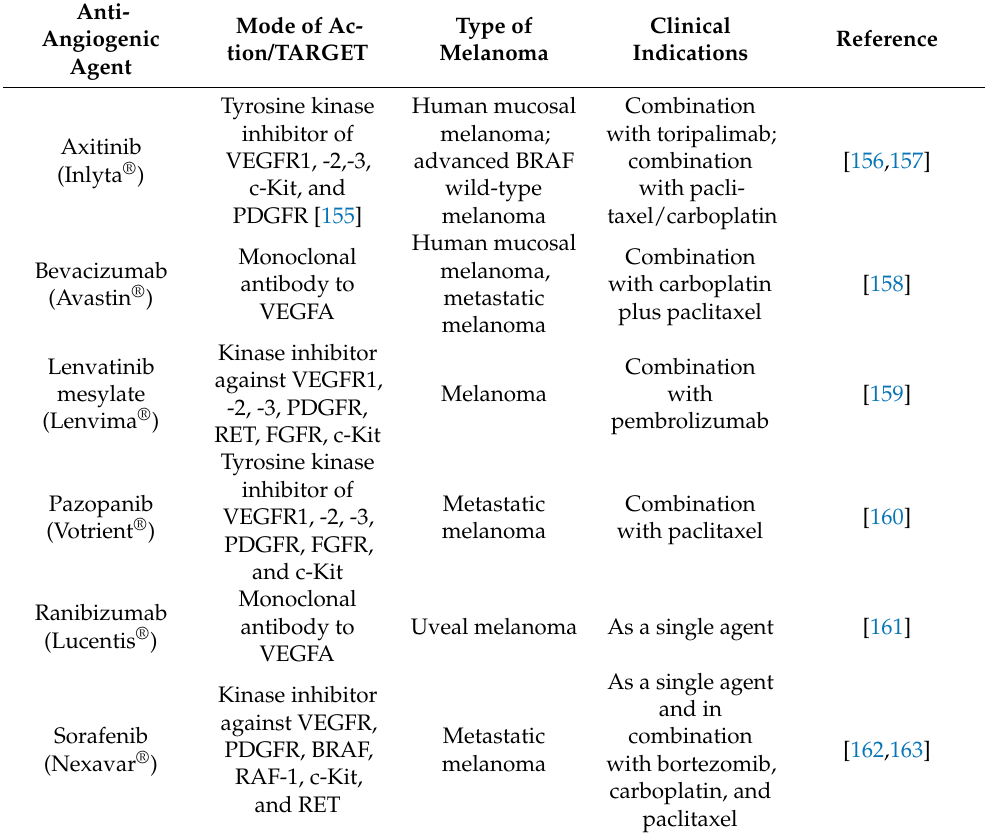
Table 1. List of anti-angiogenic drugs for